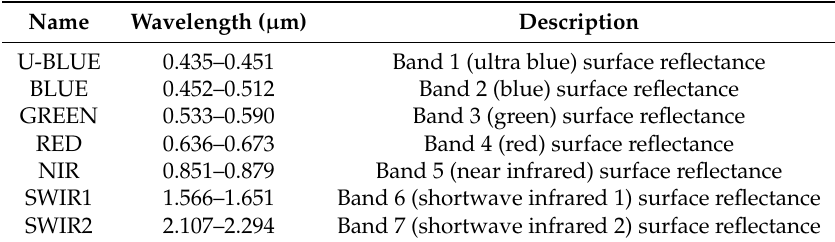
Table 2. Investigated bands of Landsat Operational Land Imager (OLI)